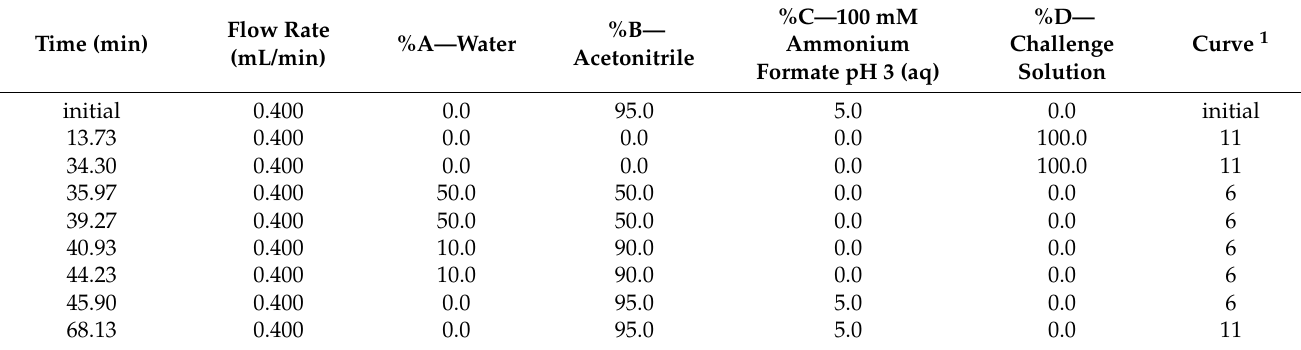
1. Curve indicates the shape of the change of the solvent composition for each gradient segment. Curve 11 is a step change at the end of the segment, and curve 6 is a linear change during the segment.